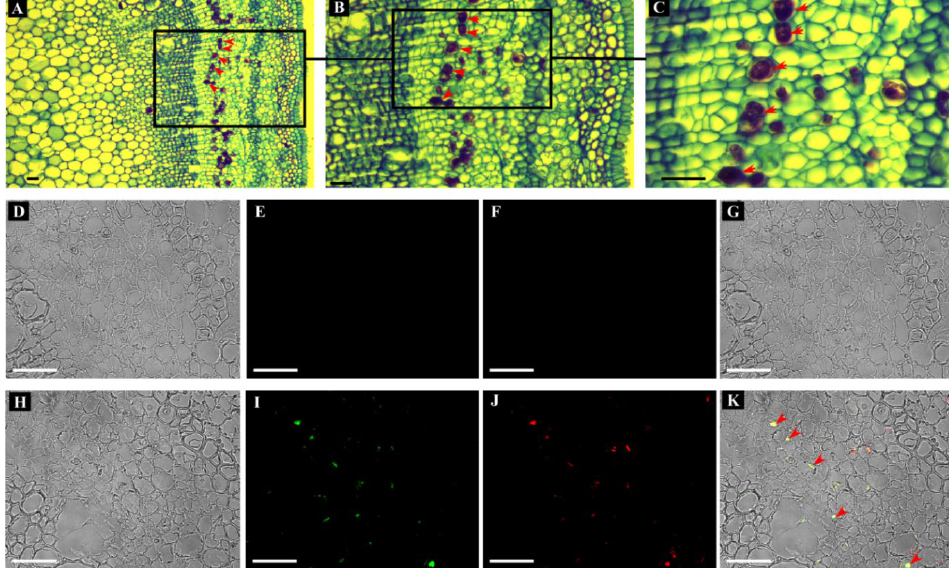
Figure 3. Immunohistochemical colocalization of HbTPS5 and laticifer-specific REF proteins by fluorescence detection. Transverse sections of young rubber stem were subjected to iodine-bromine staining, and the laticifers are visualized with a brown coloration ( A – C ; arrow heads). Similar sections were used for immunolocalization analysis ( D – K ). ( H ) Bright field image of sections used for immunolocalization in ( I – K ). Confocal microscopy images of sections reacted with the REF antibody and a secondary antibody conjugated with FITC ( I ), and the HbTPS5 antibody and a secondary antibody conjugated with DyLight650 ( J ). ( K ) shows a merged image of ( H – J ). Pre-immune controls for the proteins of REF and HbTPS5 are shown in ( D – G ). Note the co-localization of HbTPS5 antibody and REF antibody in the laticifers demonstrated by a yellow coloration of the merged signals of HbTPS5 (red) and REF (green) (arrowheads). Bars = 20 µ m.